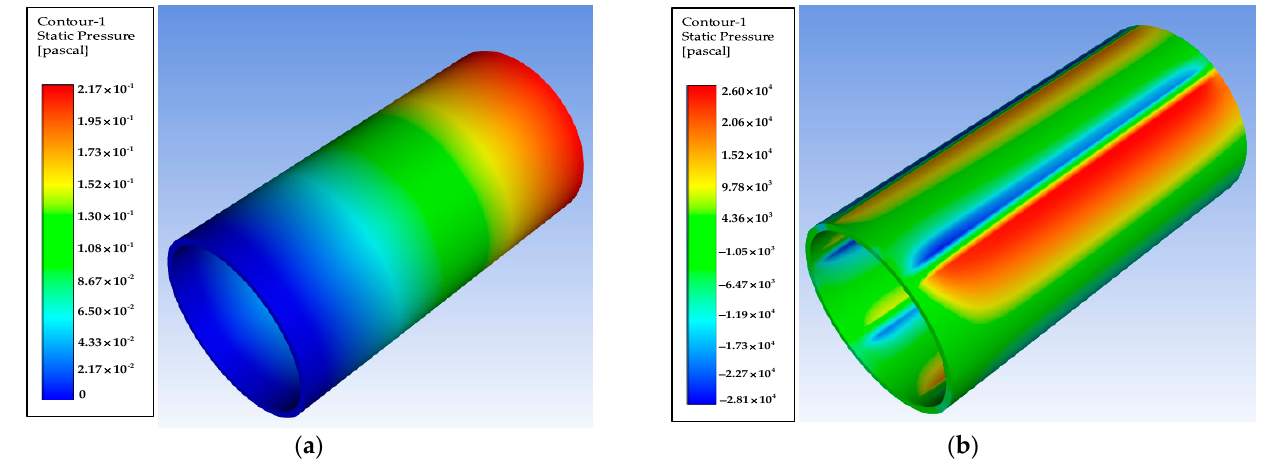
Figure 17. Airflow pressure distribution in the air gap: ( a ) Roundness error amplitude is 0 mm; ( b ) Roundness error amplitude is 0.50 mm.